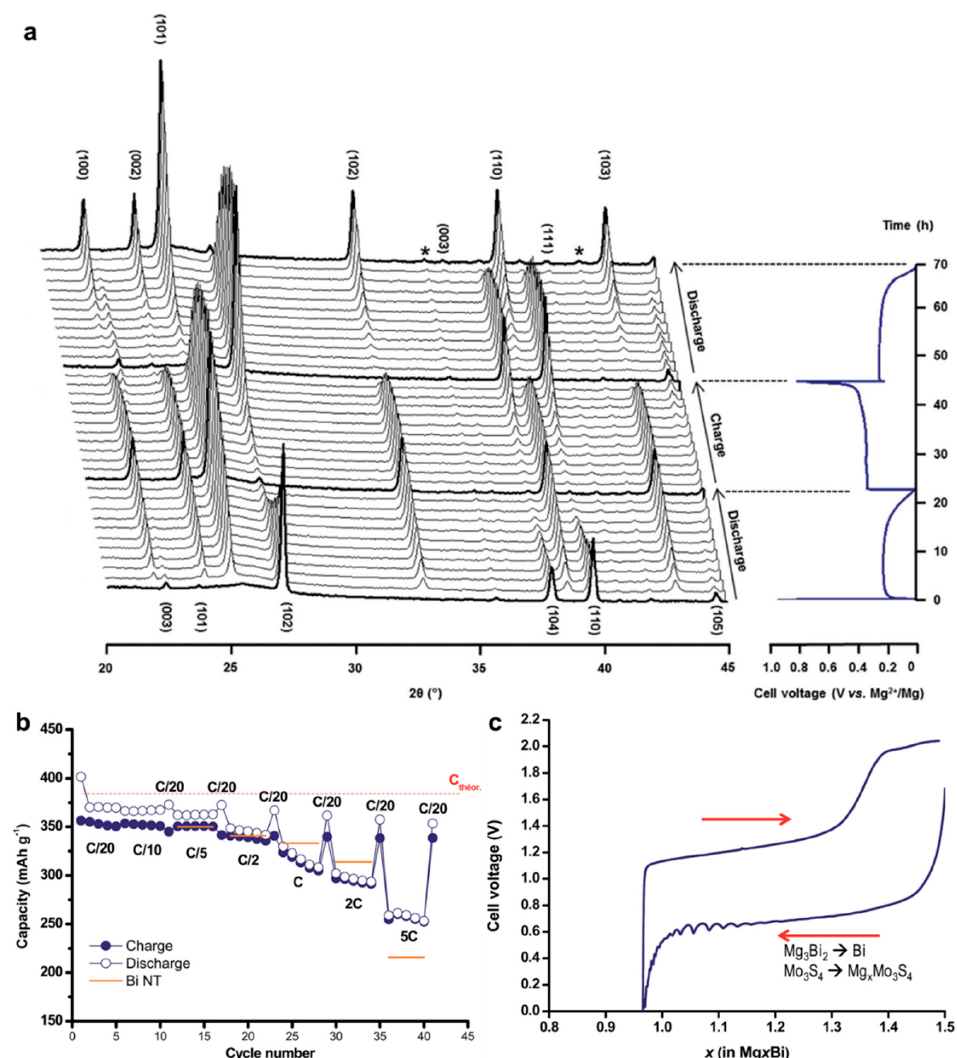
Figure 2. TEM images depicting the structure transformations of Bi during the processes of magne- siation/demagnesiation, ( a ) pristine Bi, ( b ) 50% magnesiated Bi, ( c , d ) 100% magnesiated Bi (i.e., Mg 3 Bi 2 ), ( e ) 50% demagnesiated Mg 3 Bi 2 , and ( f – h ) 100% demagnesiated Mg 3 Bi 2 (i.e., Bi). In situ heat generated by the Mg/Bi coin cell during magnesiation/demagnesiation using IMC at ( i ) C/10 and ( j ) C/5 rate, respectively. Reproduced with permission [25]. Copyright 2015, Institute of Physics.